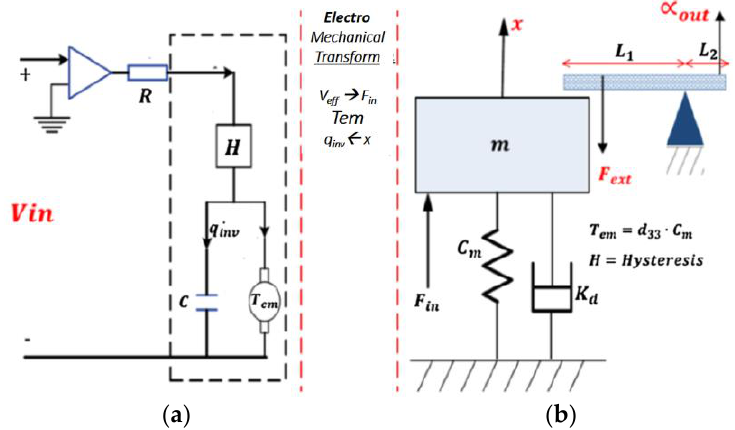
Figure 8. General model of piezoelectric positioning stage: ( a ) electrical scheme and ( b ) mechanical scheme [24].